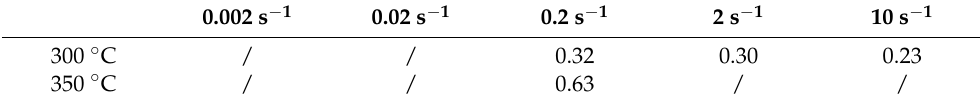
Table 1. The failure strains of the specimens deformed at the low temperature of 300 ◦ C and 350 ◦